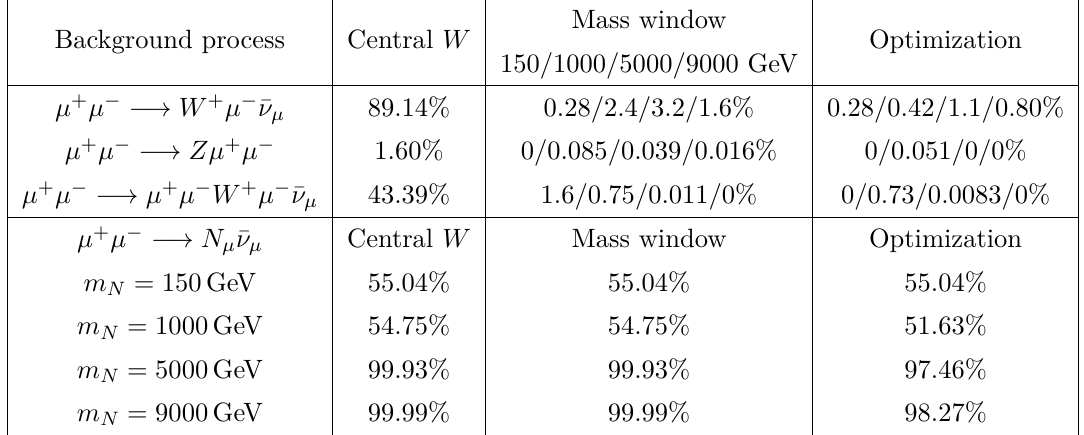
Background process